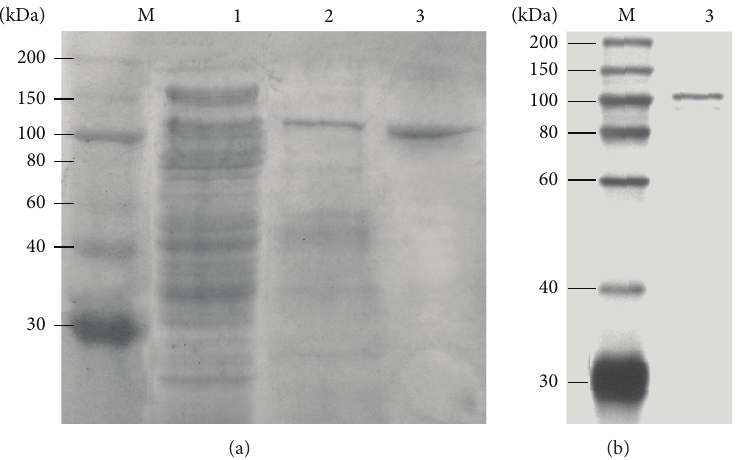
Figure 5: SDS-PAGE analysis of the samples from various steps of xanthan lyase purification by staining with coomassie brilliant blue (a) and the purified xanthan lyase by silver staining (b). Lane 1: ammonium sulfate precipitation sample; lane 2: the eluted protein solution after the phenyl Sepharose column; lane 3: the final xanthan lyase product after the Q Sepharose FF column; and lane M: the protein marker.